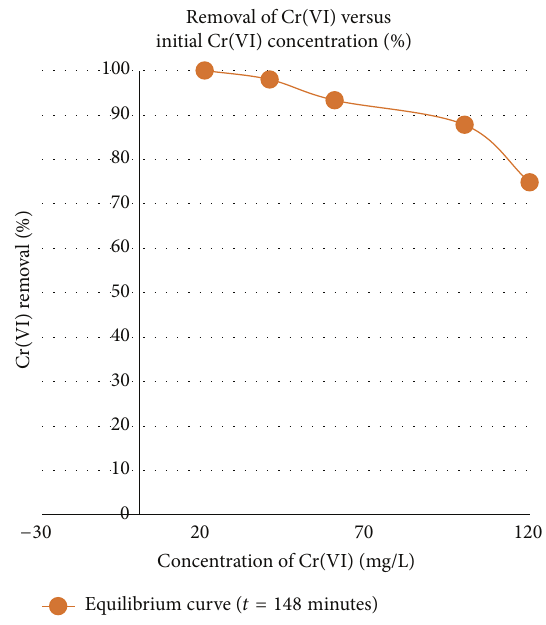
Figure 3: Effect of initial Cr(VI) concentration, pH 2.5, and absorbent dose of